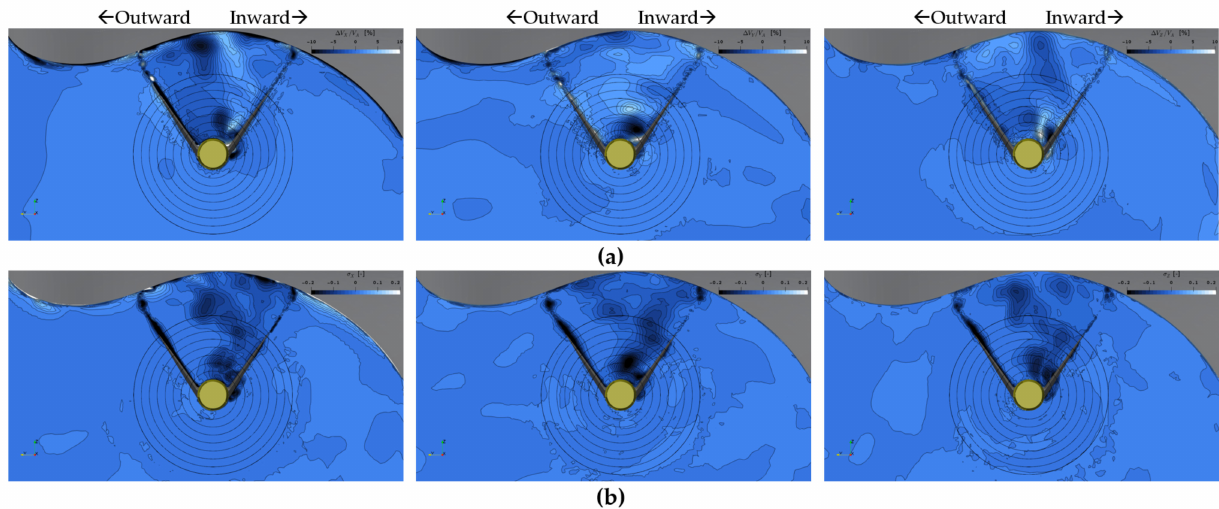
Figure 9. ProNoVi target case. Difference between RANS and ILES wake field in the Cartesian components x, y and z, velocities averaged over time, propeller plane indicated by radii sections: ( a ) velocity difference; ( b ) velocity standard deviation